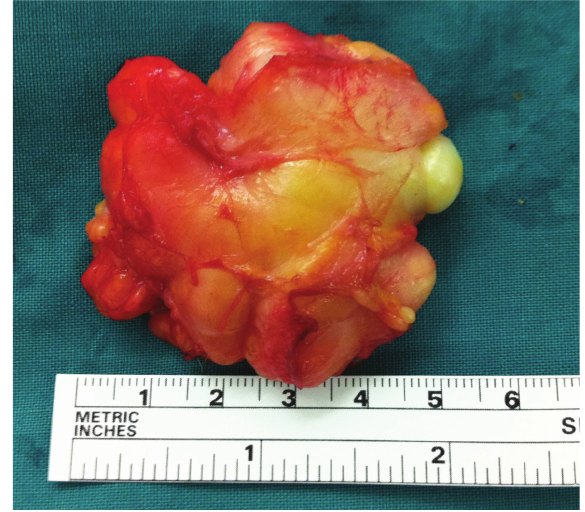
Figure 6: A lipomatous mass of 6cm in diameter.